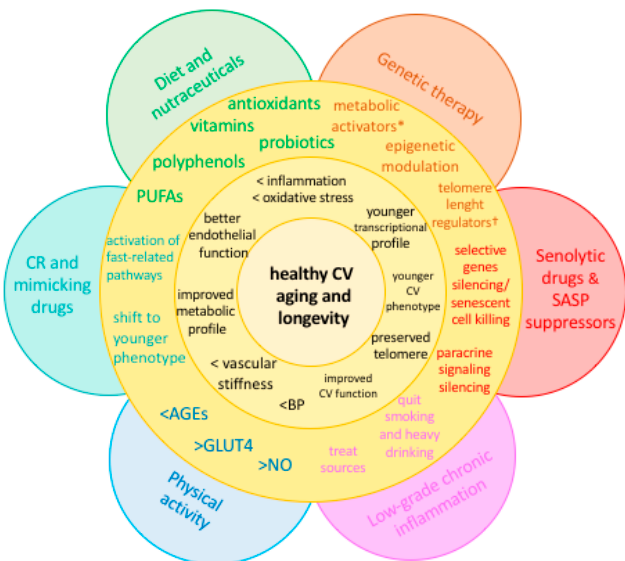
Figure 3. Current and future strategies to preserve the flower of youth. * Sirtuins and